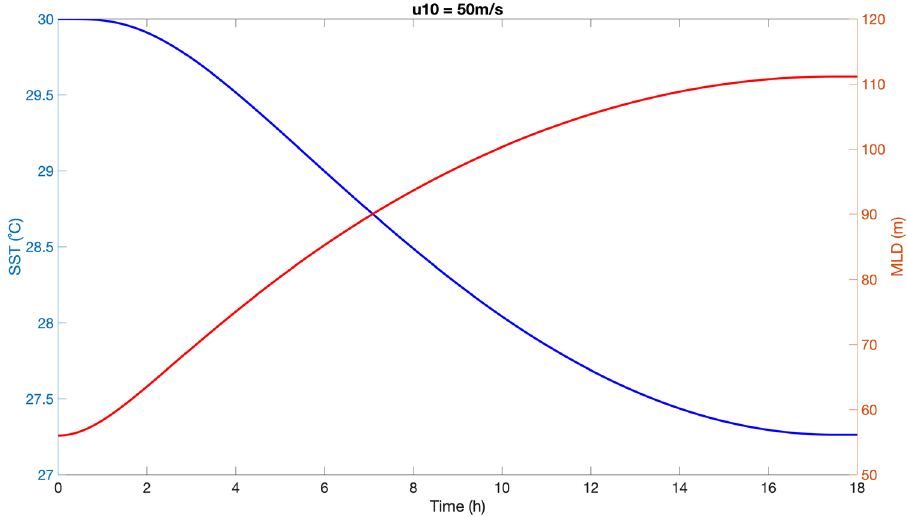
Fig. 5 Time-scales of MLD deepening and SST cooling for a hypothetical constant surface wind forcing as described by the PRT model. PRT solutions for SST - equivalent to the mixed layer temperature - and MLD for a surface wind stress of 50 m s − 1 as a function of time at 20 ∘